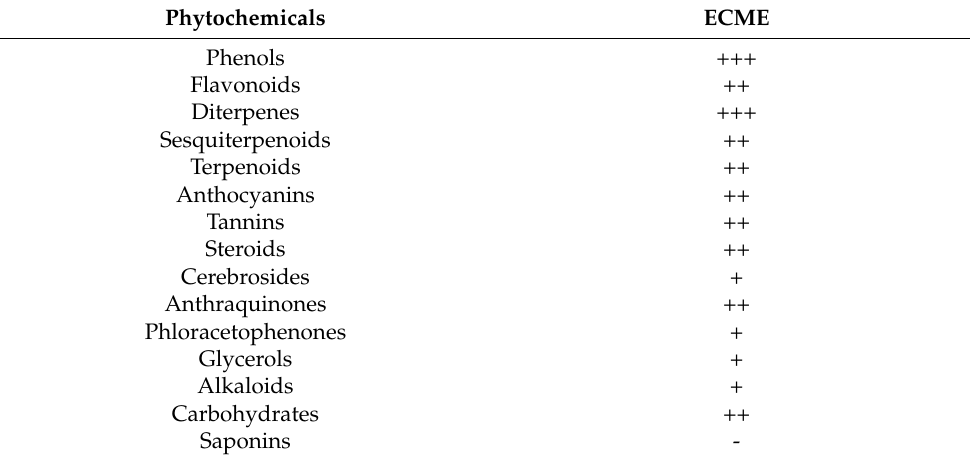
Table 1. Qualitative screening of phytoconstituents present in the methanolic extract of aerial parts of E. cactus